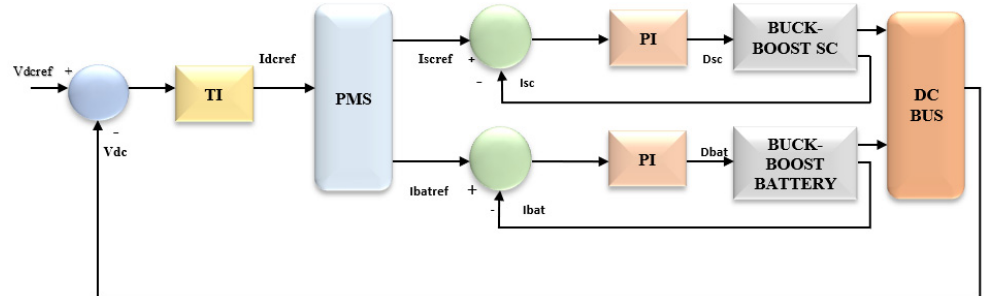
Figure 4. The proposed TI controller-based DC bus control scheme.